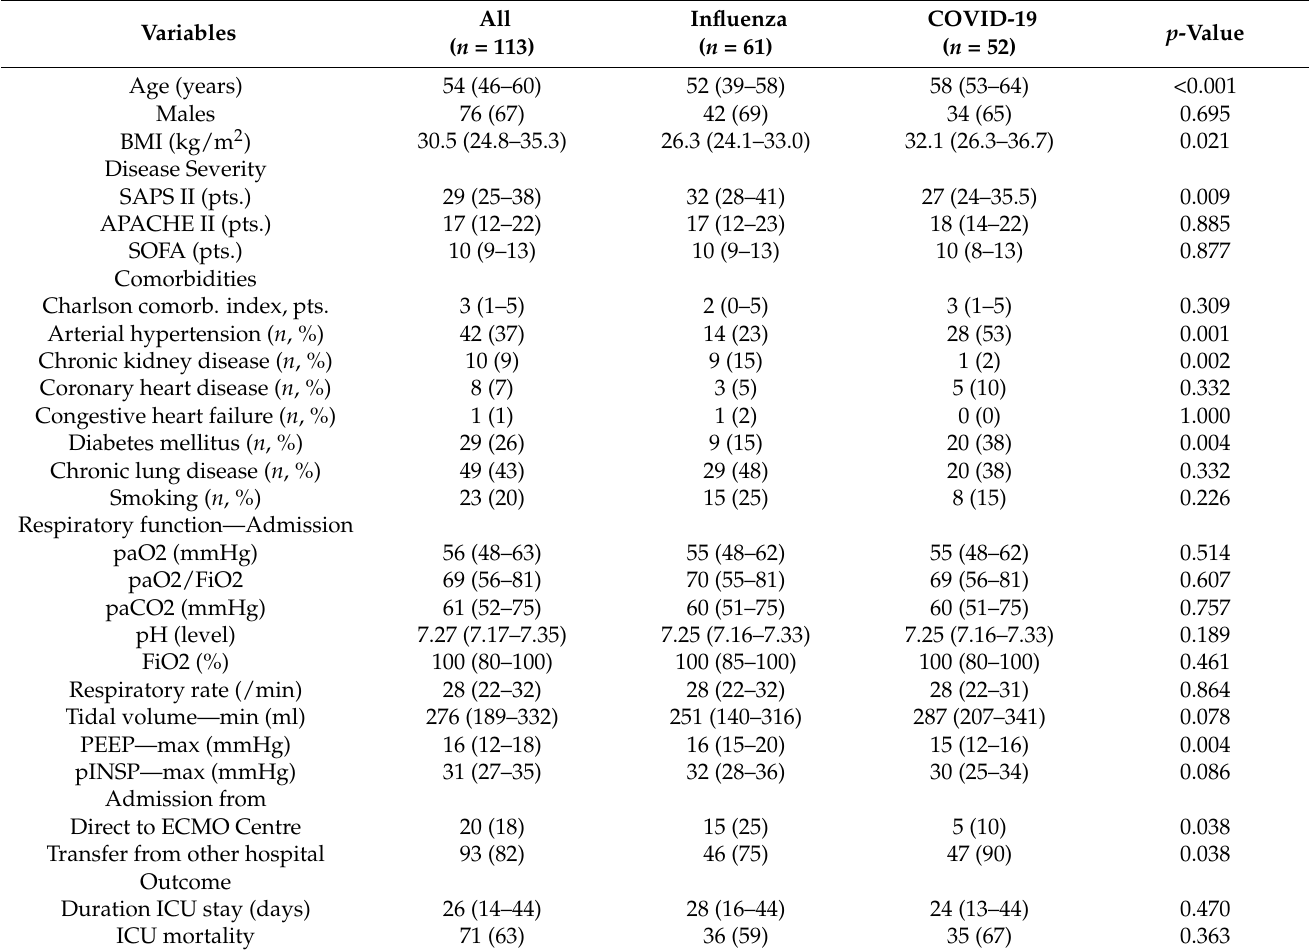
Table 1. Baseline demographic and clinical characteristics on ICU